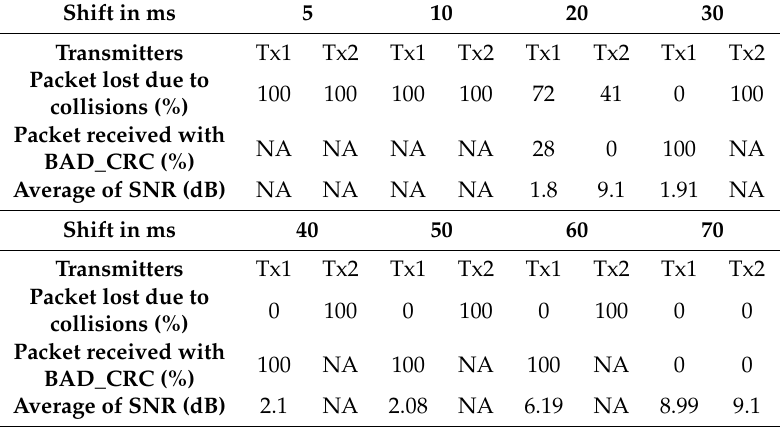
Table 5. Statistics for collided packets for the case when the interferer has a 12 dB higher RSSI than the interfered transmission for the second setting from Table 1. NA stands for Not